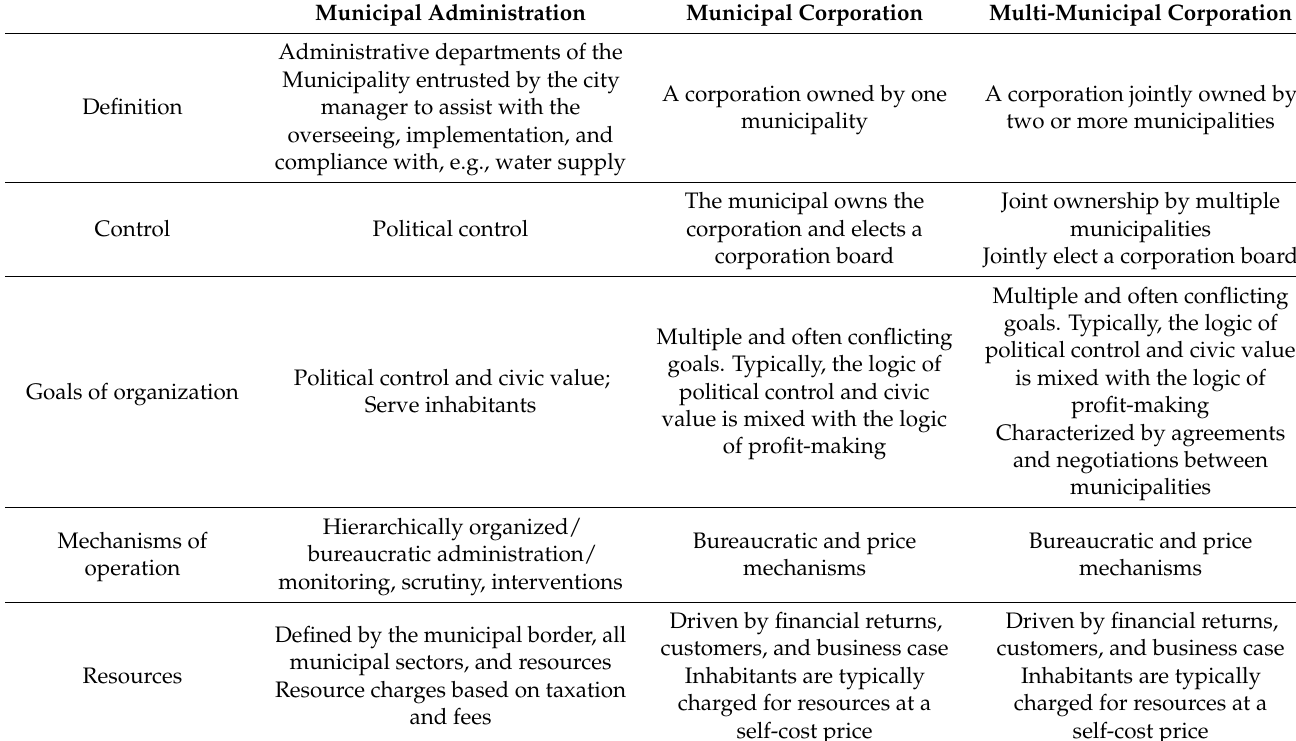
Table 1. Different forms of municipal organization of water and sewage. Based on